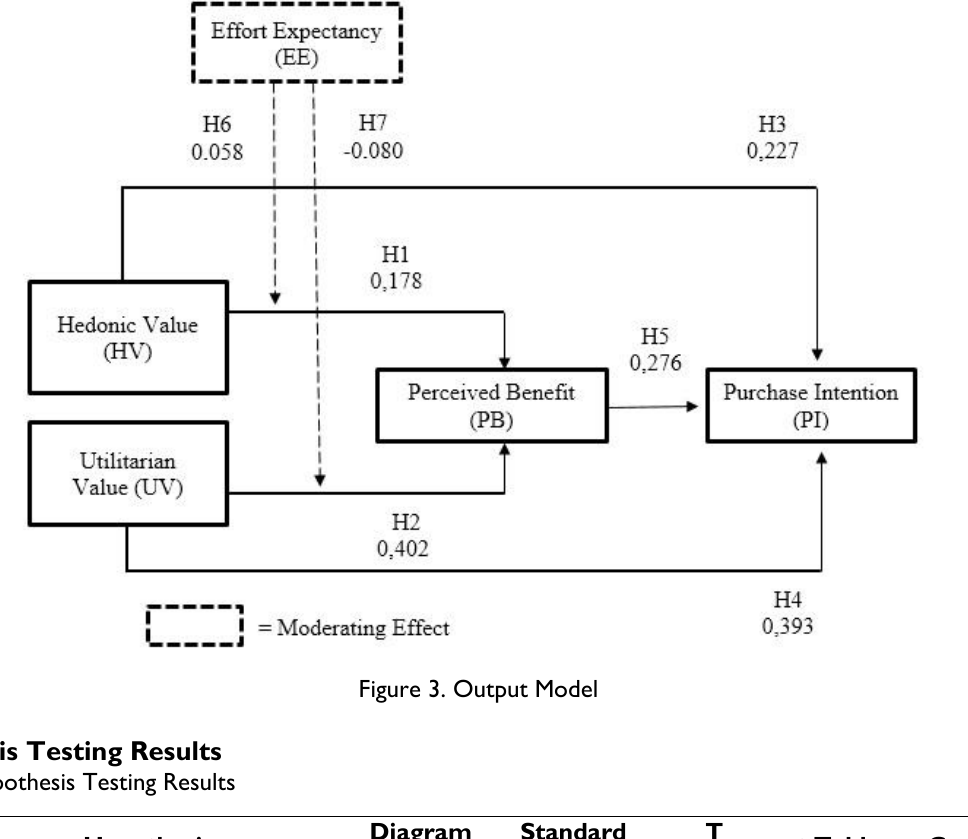
Figure 3. Output Model